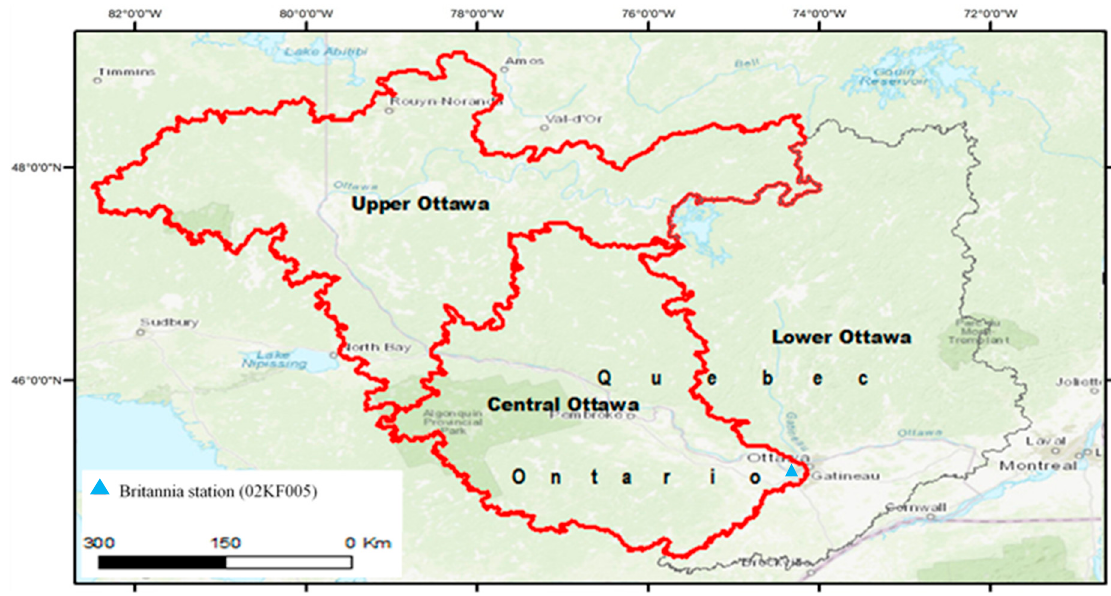
Figure 2. Selected study area: upper and central Ottawa watersheds.